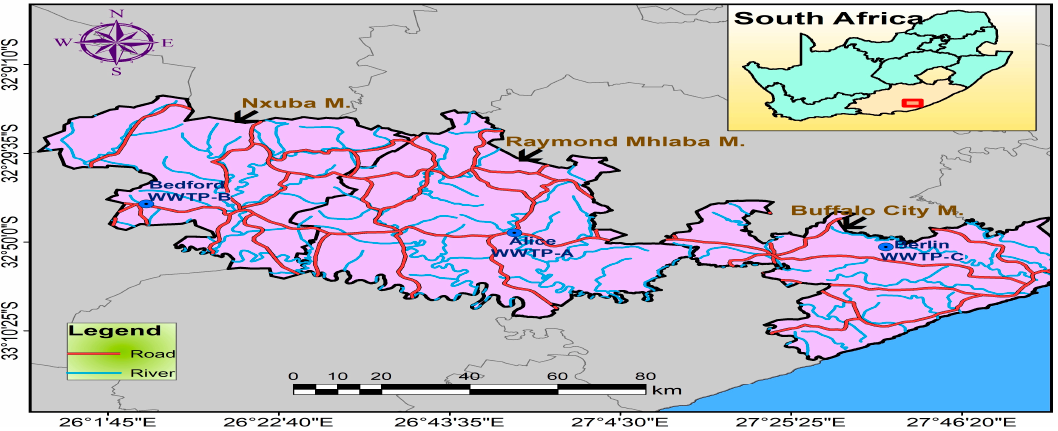
Figure 1. Location of the investigated area.